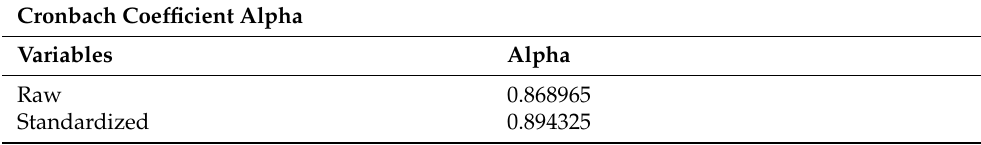
Table 3. Cronbach’s Alpha